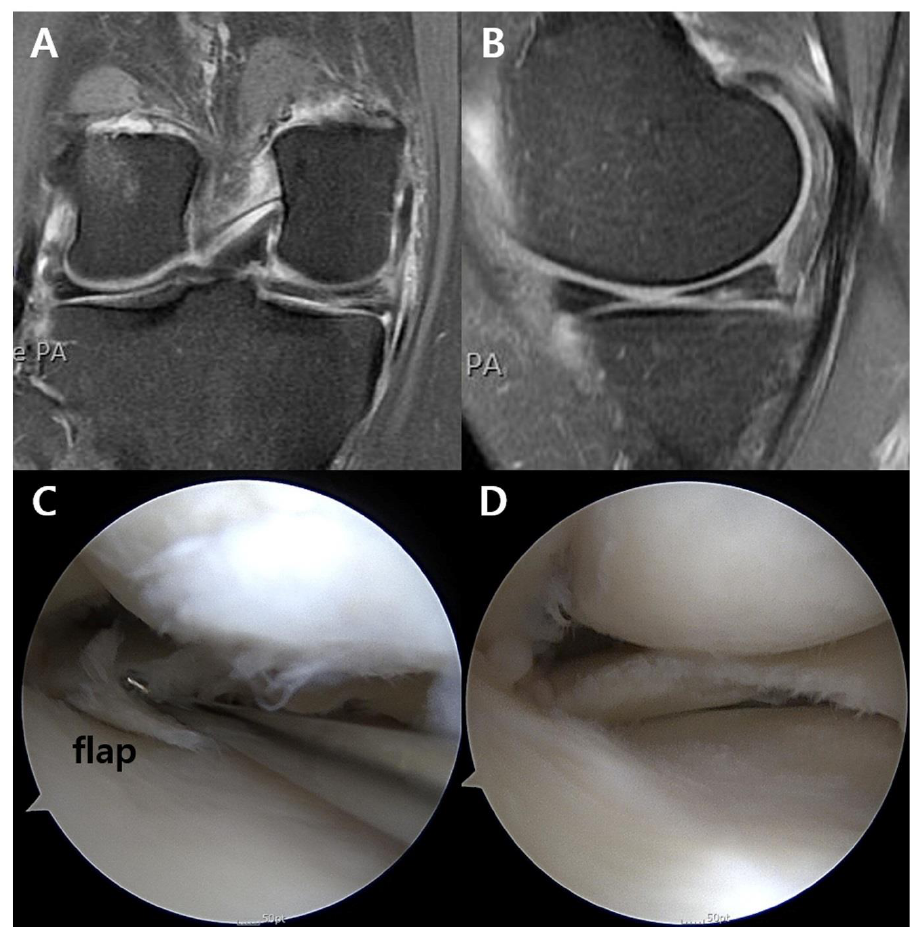
Figure 1. Unstable flap at the posterior horn of the medial meniscus in the right knee. ( A ) Coronal and ( B ) sagittal MRI images did not definitely show the flap, which was ( C ) confirmed and ( D ) debrided during arthroscopy. MRI, magnetic resonance imaging.